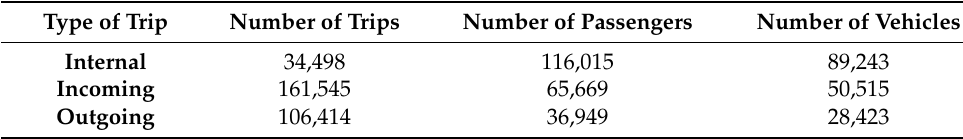
Table 2. Estimation of the average circulating fleet in the city of